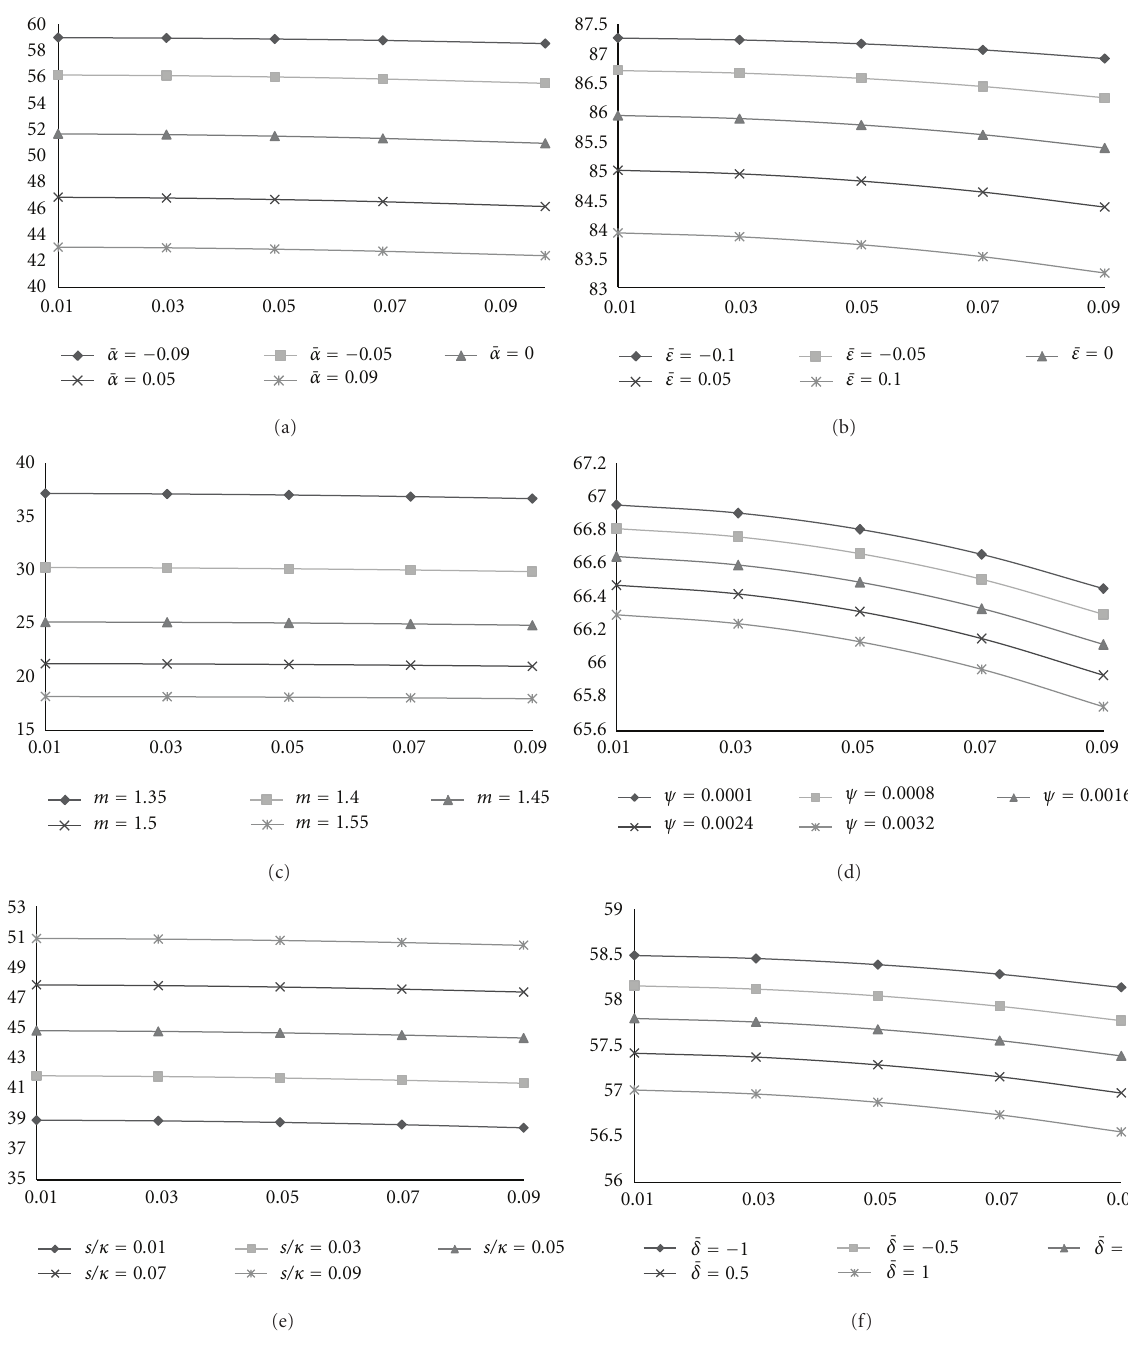
Figure 3: (a)–(f) The distribution of load-carrying capacity with respect to σ for various values of α , ε , m , ψ , s/κ and δ .